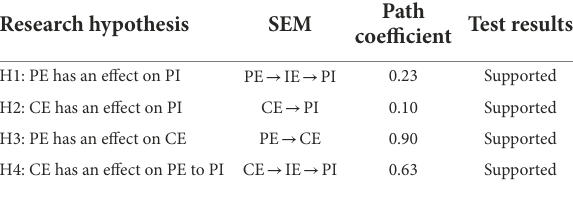
TABLE 4 Model hypothesis